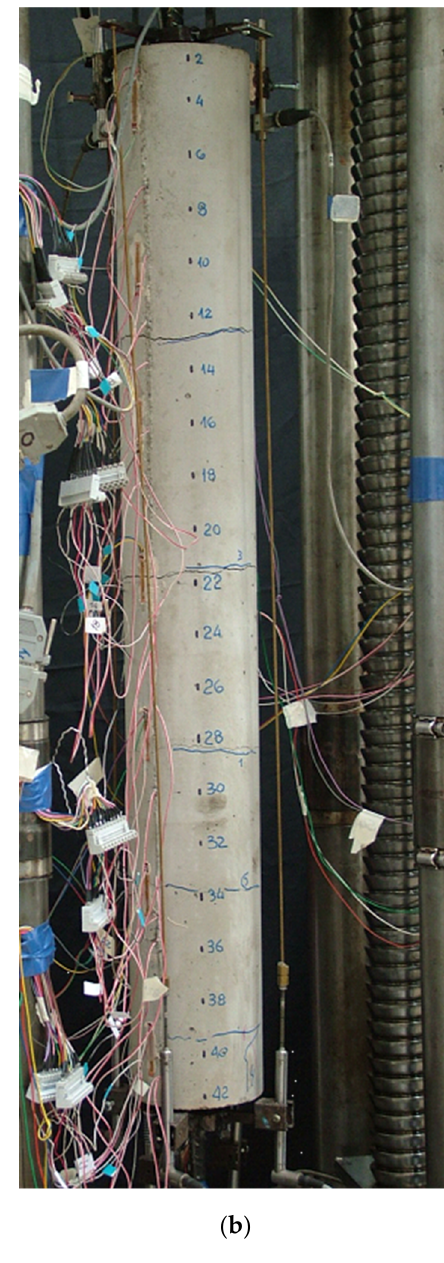
Figure 10. Reinforced concrete specimen n.1 tested at the Laboratory of the University of Pisa: ( a ) specimen before the test, ( b ) cracked specimen after the test.